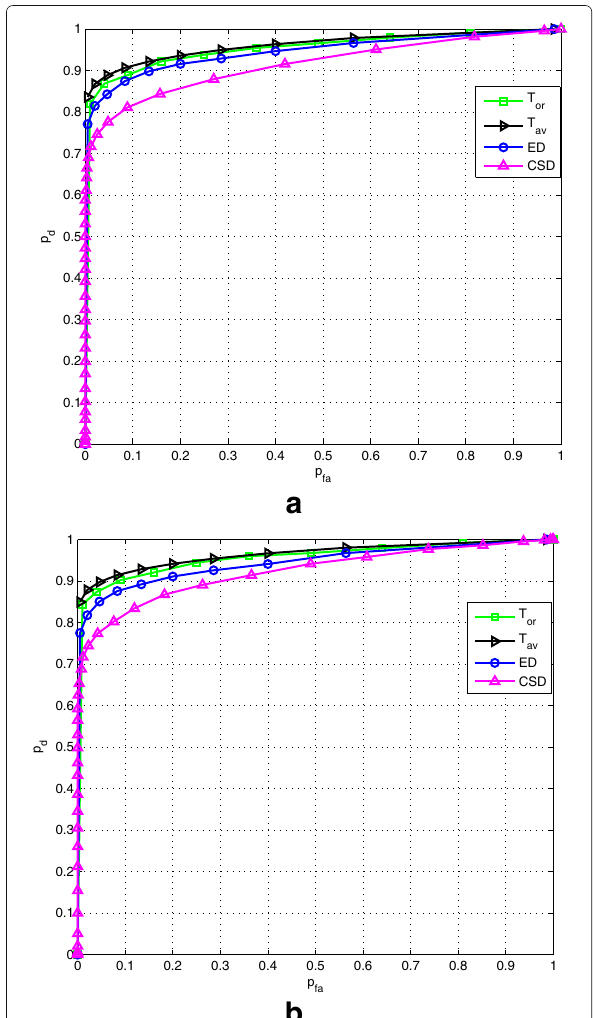
Fig. 7 ROC curves over Rayleigh fading channel for a ) N s = 4 sps and b N s = 8 sps for N=1000 samples and average SNR = − 5 dB